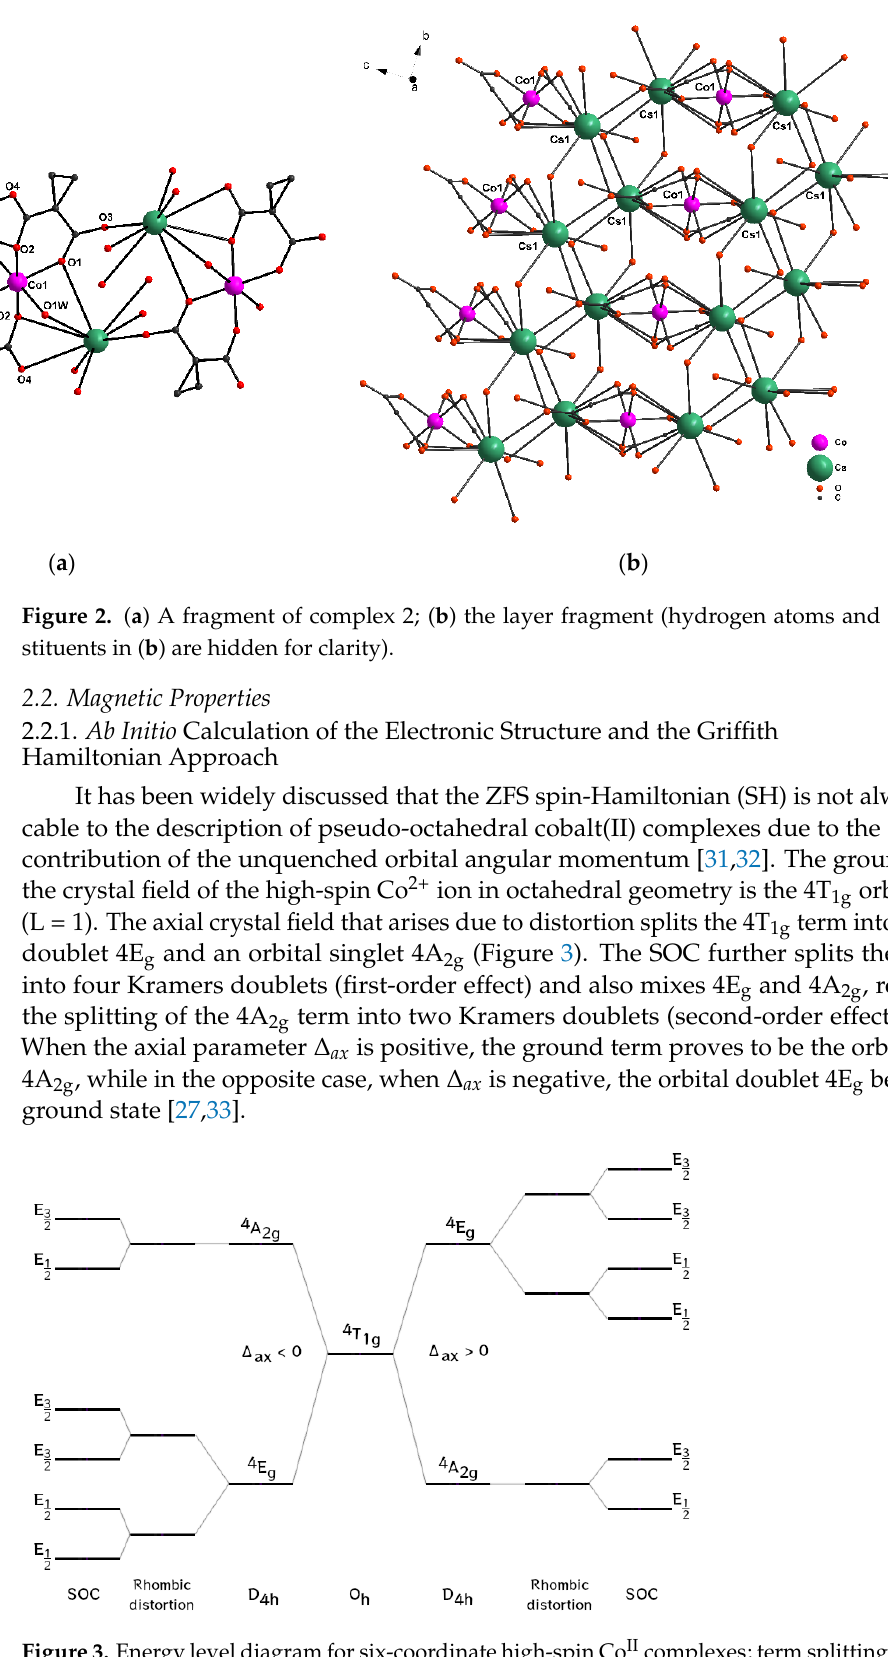
Figure 3. Energy level diagram for six-coordinate high-spin Co II complexes; term splitting in spherical symmetry, splitting due to lowering to D 4h symmetry, and further splitting after inclusion of SOC (in a double-group notation). Table 1. SA-CASSCF-calculated spin-free and spin-orbit state energies (cm − 1 ) for 1 and 2.